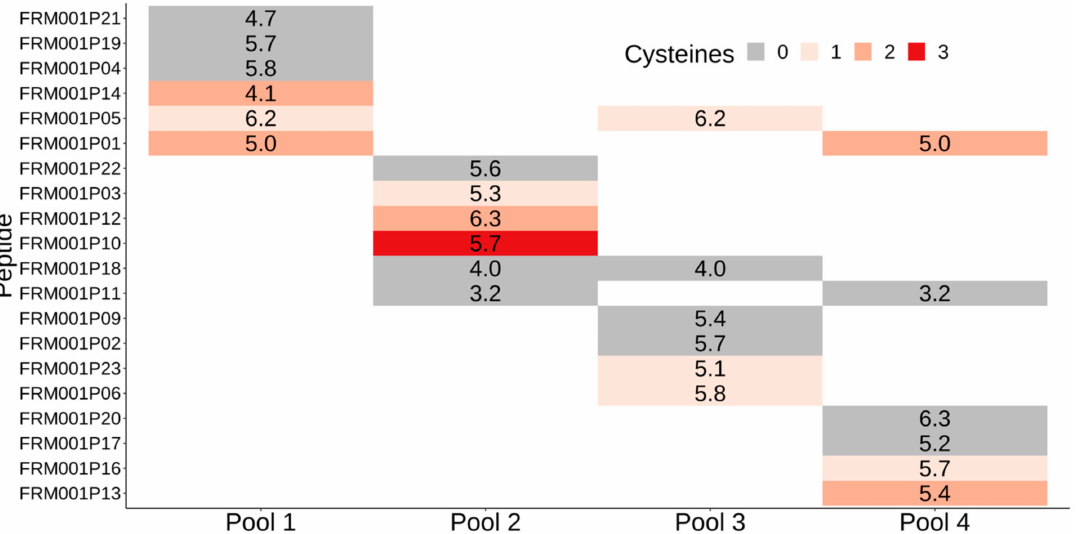
Figure 4. Peptide pooling scheme shows in each column one peptide pool where individual peptides are shown as rows. The color of each row corresponds to peptide cysteine content as depicted in the legend. The numbers shown in boxes indicate the peptide RT in seconds. Some peptides were added to multiple pools to achieve maximum of six peptides per pool and/or assure presence of three cysteine-containing peptides per each pool.